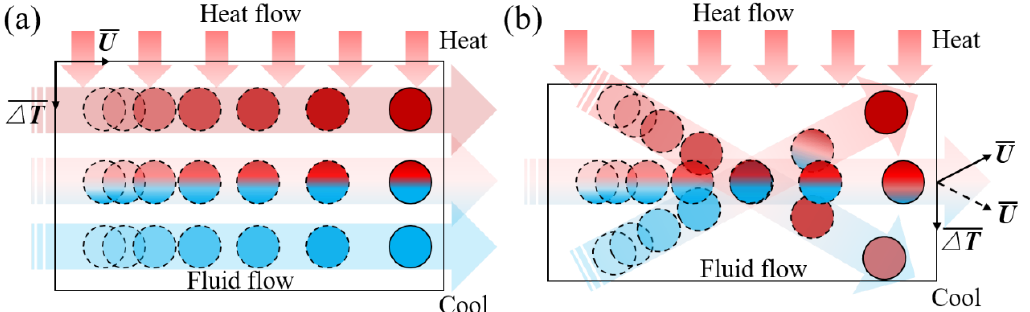
Figure 11. Synergy model between velocity and thermal flow fields in STD and TOE working channel: ( a ) STD channel; ( b ) TOE channel.